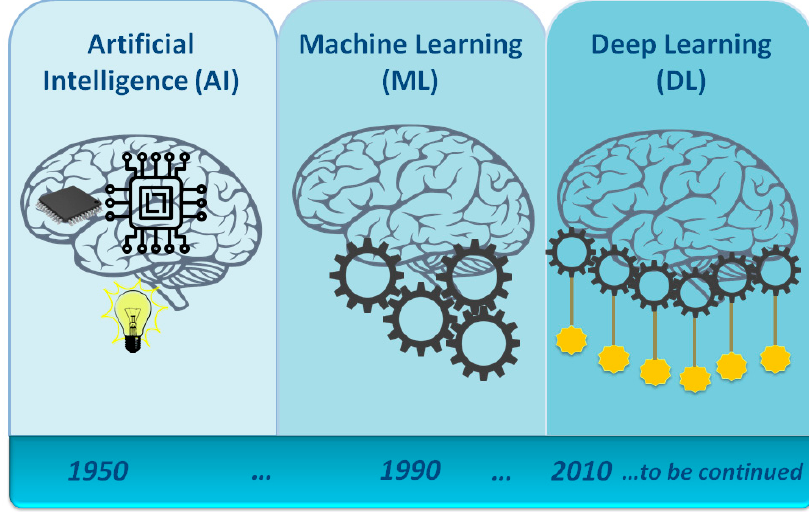
Figure 6. Artificial Intelligence, Machine Learning, and Deep